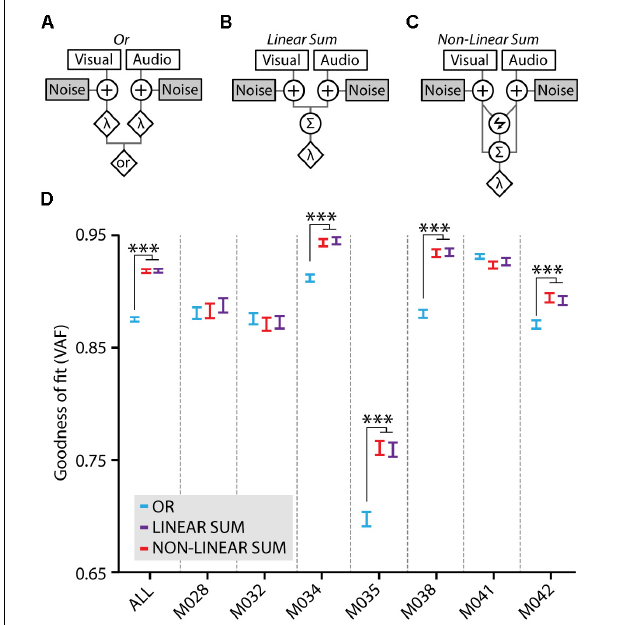
FIGURE 5 | Model fits to the behavioral data. (A) The Or model treats the visual and auditory inputs as two separate channels which both perform an independent detection of the stimulus when either the visual or the auditory component crosses the threshold ( λ ). Both channels are contaminated with independent noise. (B) In the Linear Sum model visual and auditory signals are integrated using linear summation. Independent early noise is added to the sensors and the two signals are summed using a weighted linear sum ( (cid:54) ) after which a single multisensory threshold ( λ ) determines whether a response is made. (C) The Non-linear Sum model adds a multiplication factor (lightning symbol) to the visual and auditory summation. Models adapted from Jones (2016). (D) Model fits to the average behavioral data of all mice (ALL) quantified as variance accounted for (VAF), higher values indicate a better model fit. Fits for the behavioral data of individual mice are also shown, the data of four mice show a significantly better fit for the Linear Sum (purple) and the Non-linear Sum (red) compared to the Or model (blue; one-way ANOVA with post hoc Tukey–Kramer, ∗∗∗ p <